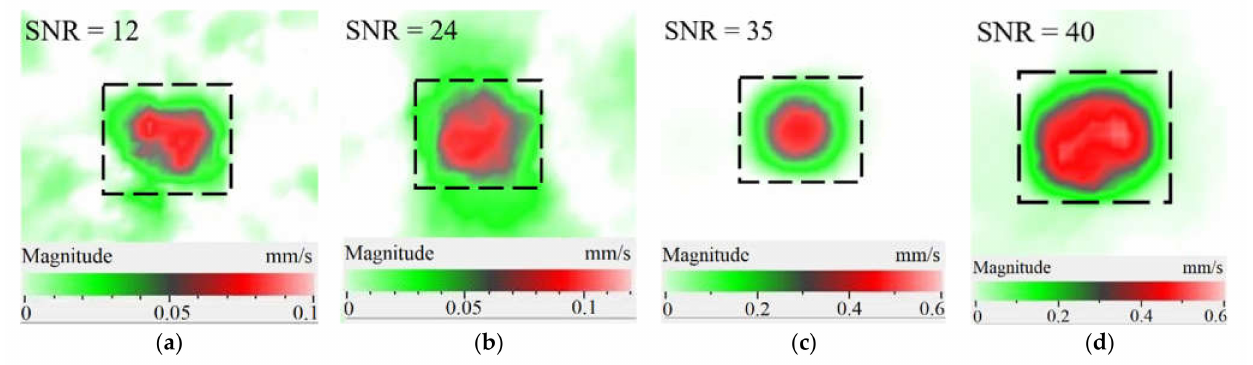
Figure 5. LDR vibrations over rectangular FBH: ( a )—by x coordinate (2344 Hz frequency), ( b )— y (2563 Hz), ( c )— z (2750 Hz), ( d )—frequency band data (2334–2750 Hz).